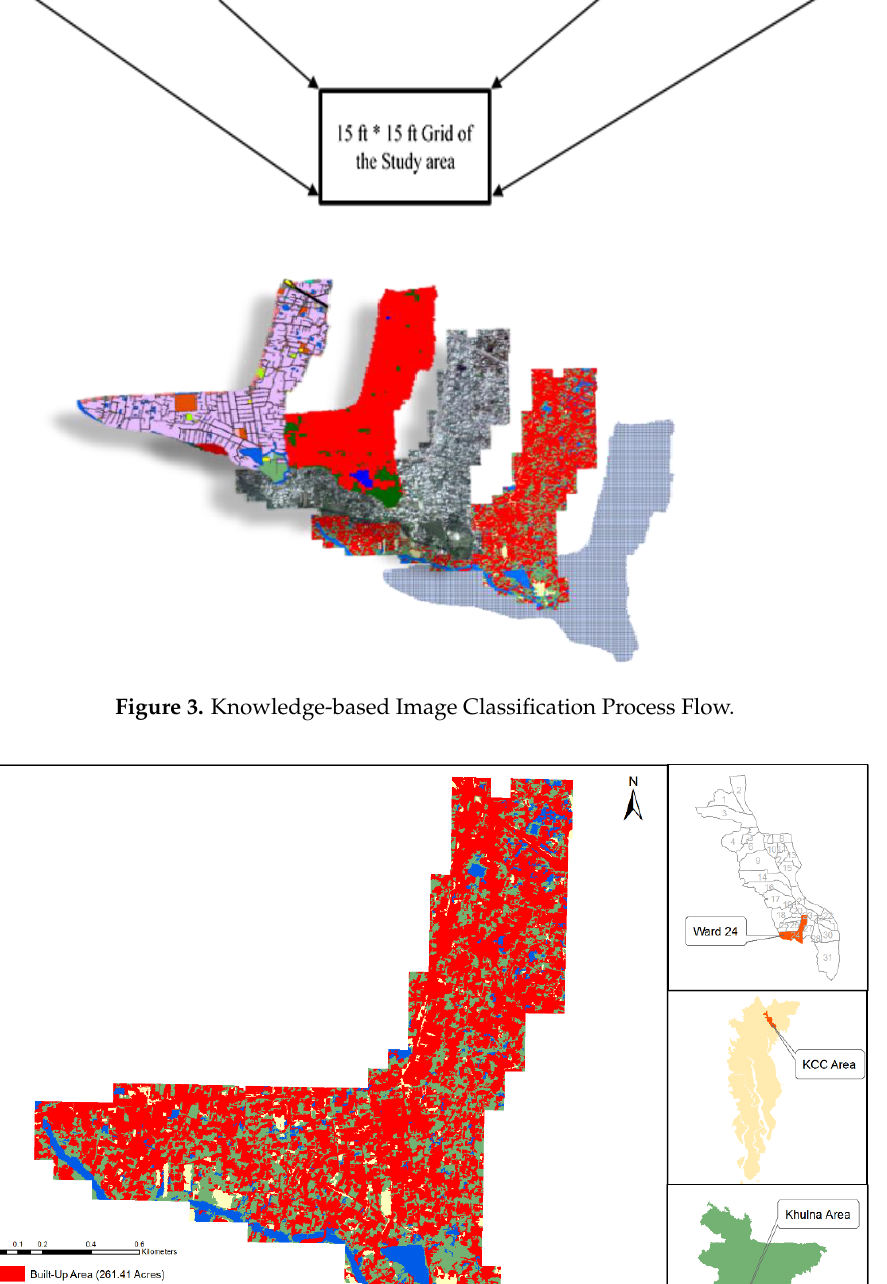
Figure 4. Land-Cover Map of Ward 24.